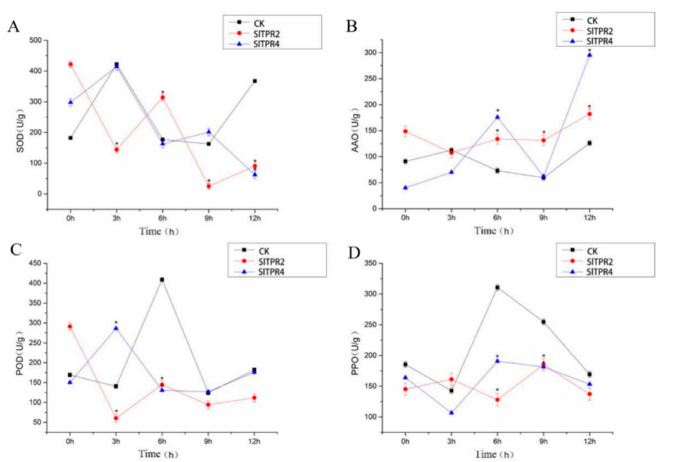
Figure 5. Effects of B. cinerea stress on the SOD ( A ), AAO ( B ), POD ( C ), PPO ( D ) of control and SlTPR2 , SlTPR4 silenced tomato. Error line indicate the standard deviation of three independent biological replicates. ANOVA was used for significance analysis. “*” represents a significant difference between the data point and control ( p <